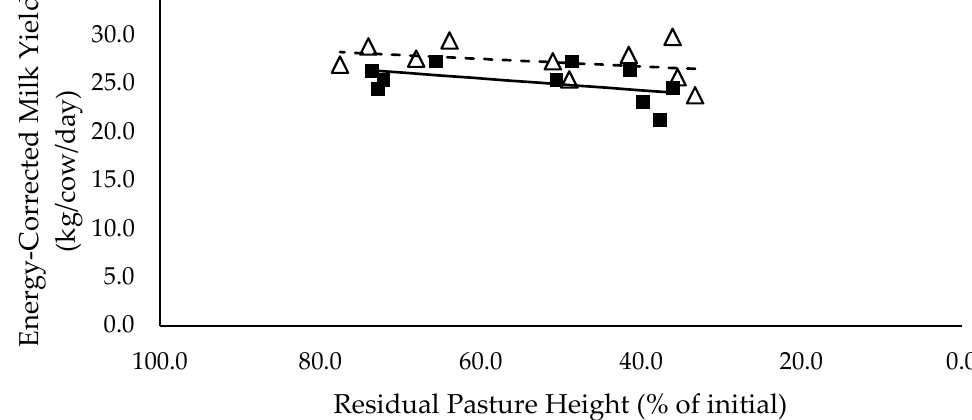
Figure 8. The relationship between energy corrected milk yield (kg/cow/day) and residual pasture height (% of initial) for high ( ■ ) and low (Δ) mixed ration levels. Lines were fitted for high (solid) and low (dashed) mixed ration levels.